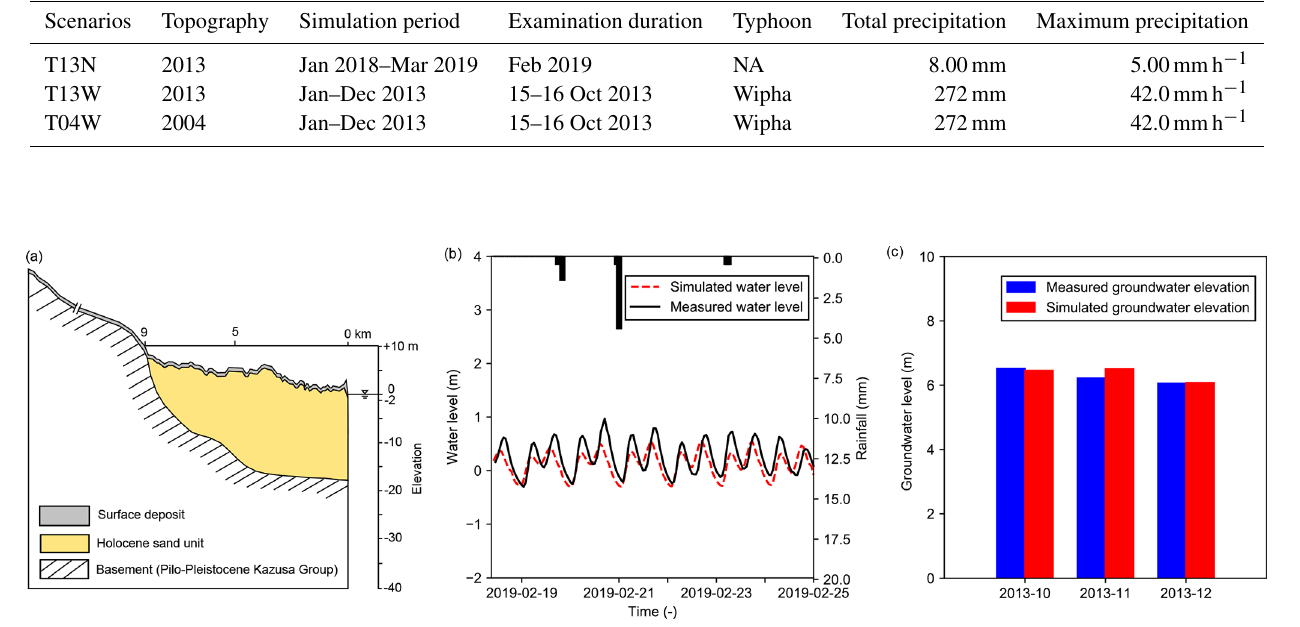
Figure 2. Simplified geological cross section used in this model; calibration and validation of the dynamic flood model. (a) Modelled geological cross section. Location of the cross section A–A (cid:48) is shown in Fig. 1b. (b) Calibration of river water levels at the Torabashi gauging station, the location of which is indicated in Fig. 1b. (c) Comparison of groundwater levels in three consecutive months including the examination period at the Kujukuri_1 groundwater observation well, the location of which is also indicated in Fig.